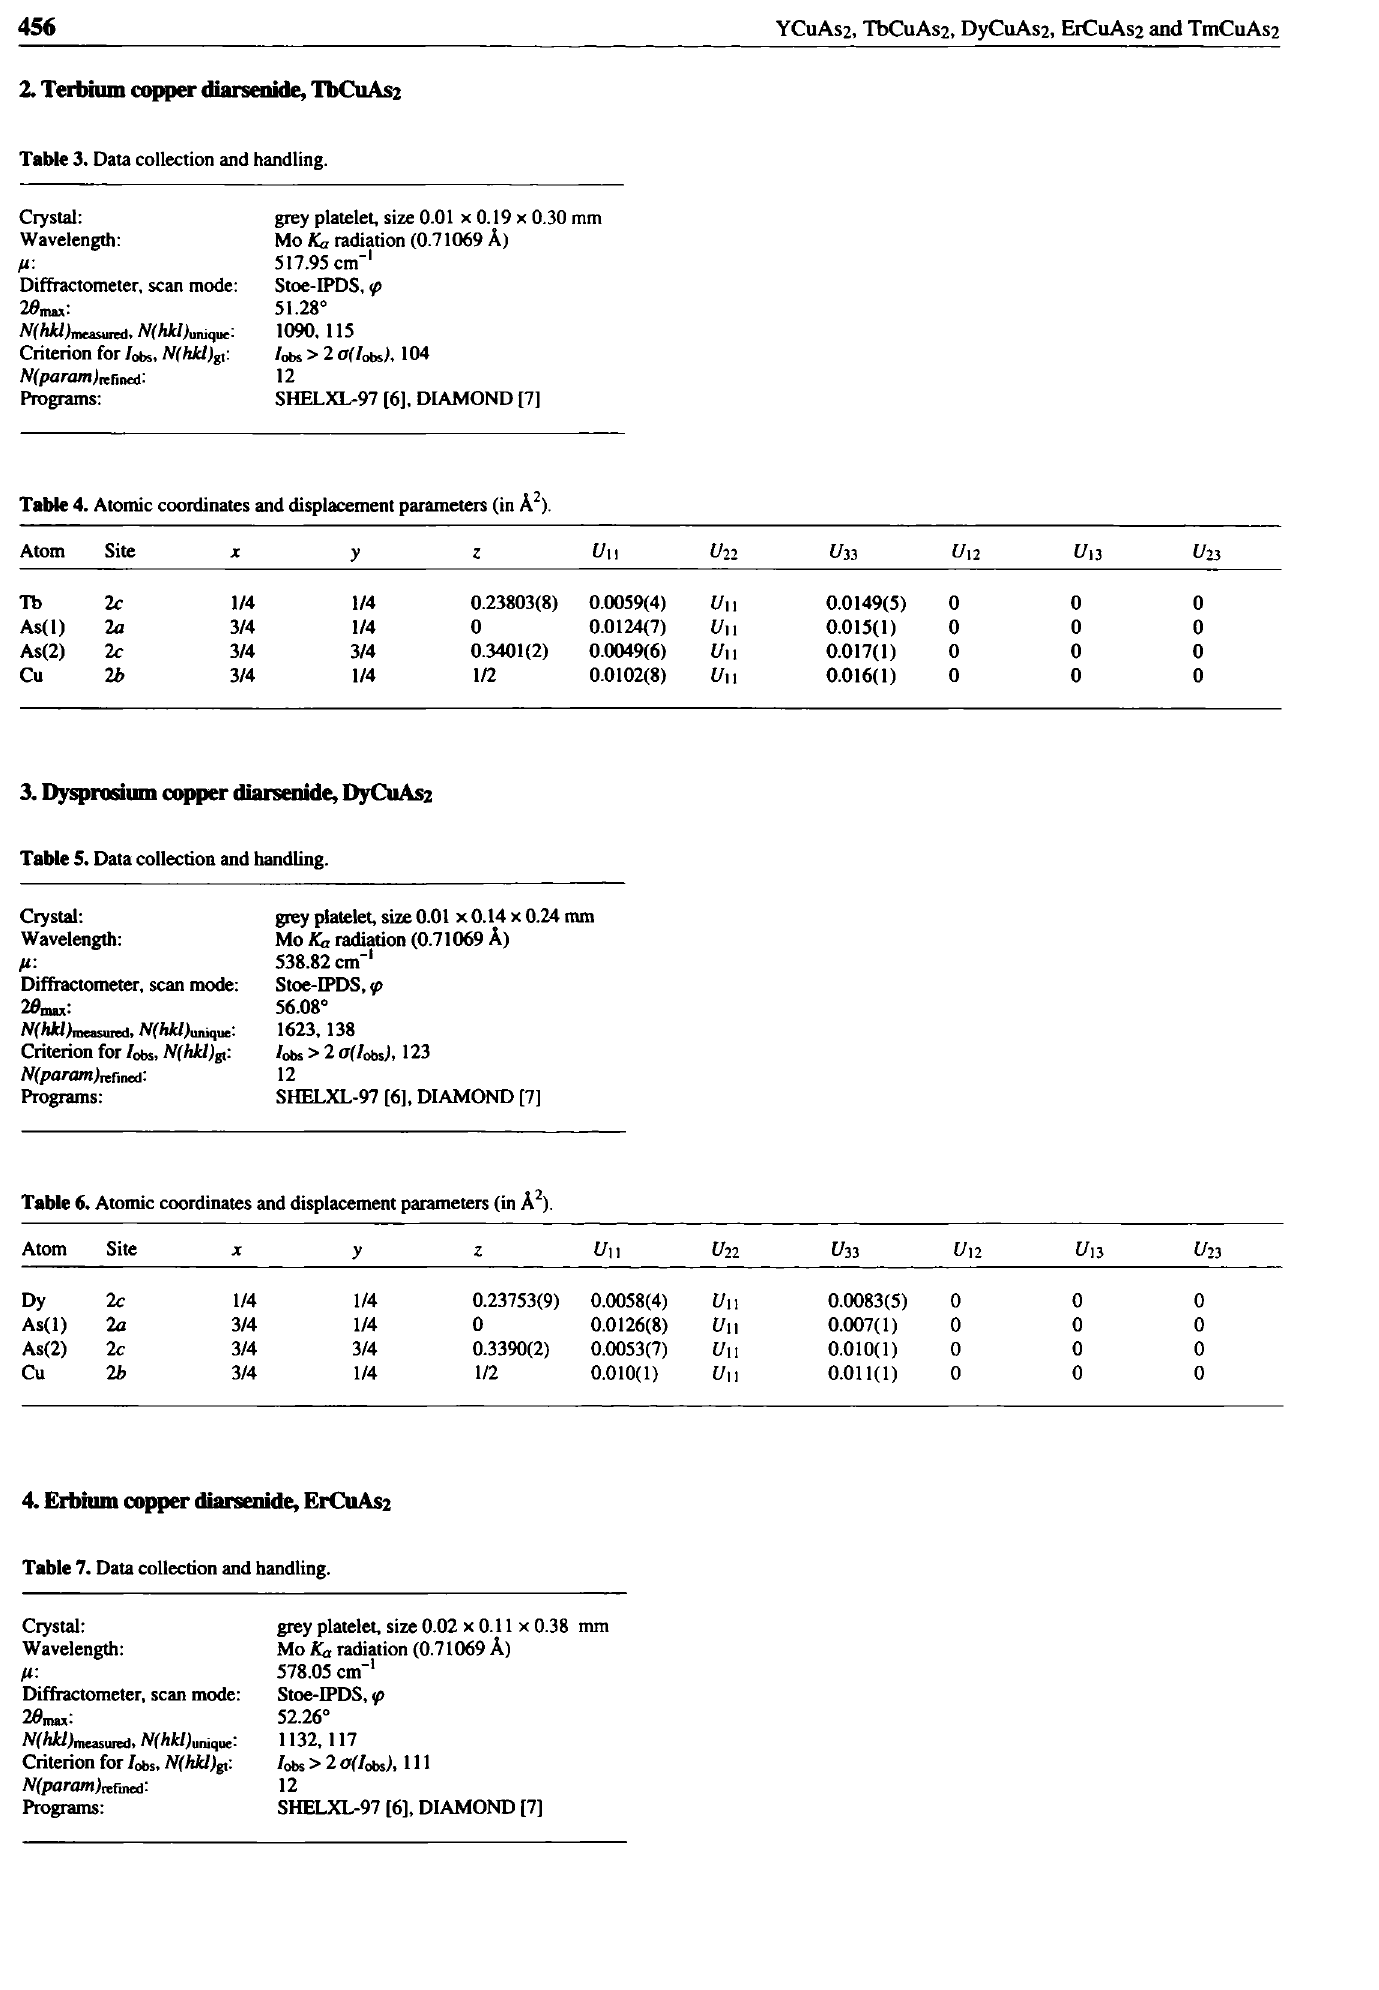
Table 3. Data collection and handling.